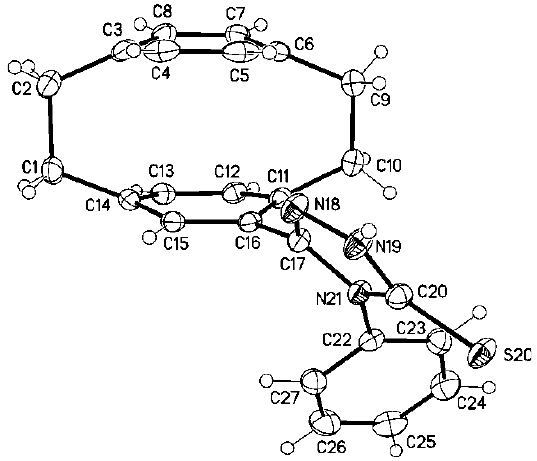
Figure 6. Molecular structure of compound 12a identified according to the IUPAC nomenclature as 5-(1,4(1,4)-dibenzenacyclohexaphane-1 2 -yl)-4-phenyl-2,4-dihydro-3 H -1,2,4-triazol-3-thione (displacement parameters are drawn at a 50% probability level).